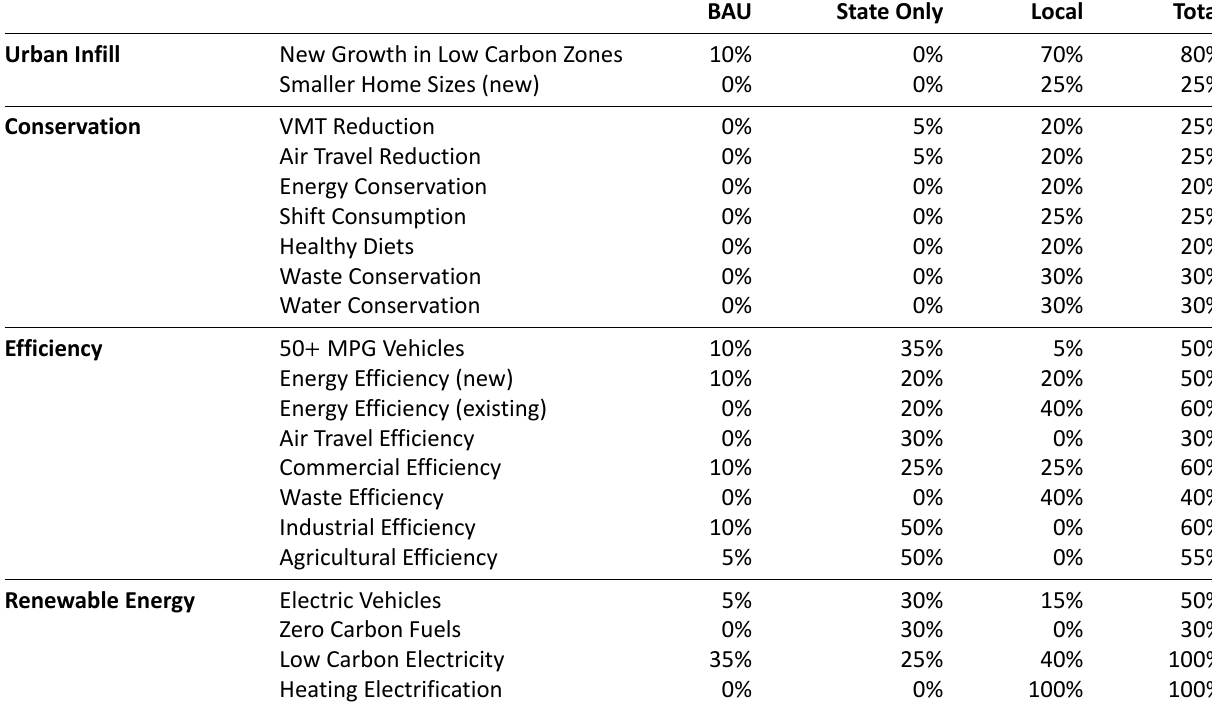
Table 1. Adoption rates of intervention areas in the year 2050.